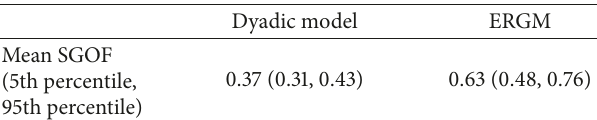
Table 5: Spectral goodness of fit results of the dyadic model and